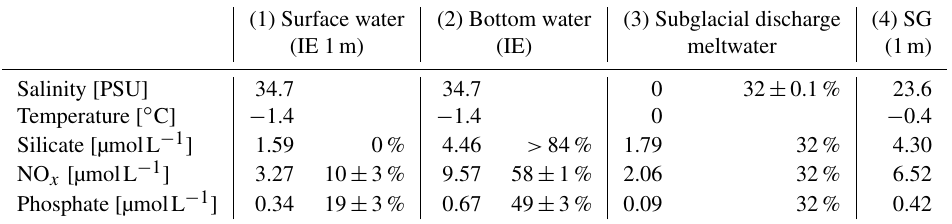
Table 1. Properties of (1) marine surface and (2) marine deep water (both station IE), (3) subglacial discharge meltwater, and (4) station SG surface water and the relative contribution of the water types 1 to 3 to form water type 4. The calculations are given in the Supplement and are based on different salinities and nutrients in the four water